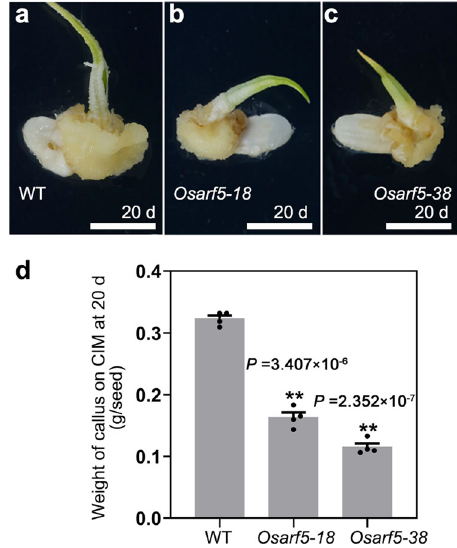
Fig. 2 OsARF5 is involved in scutellum-derived callus